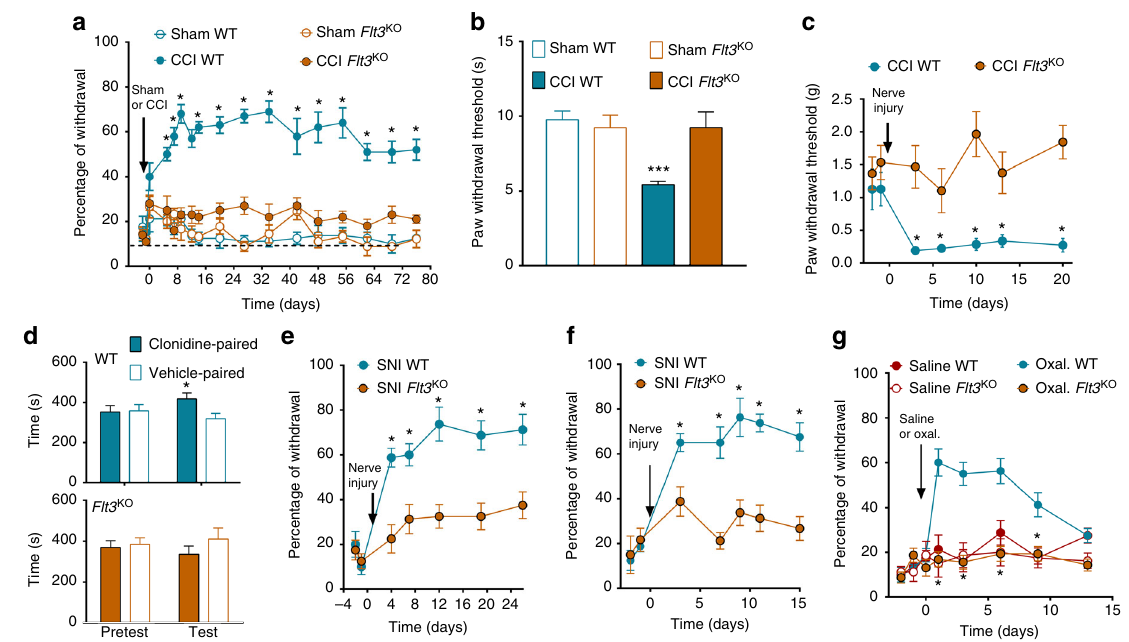
Fig. 3 FLT3 is critical for the development of pain hypersensitivity. a – g Flt3 -knockout ( Flt3 KO ), compared to wild-type (WT) animals, showed marked reductions of hypersensitivity to mechanical nociceptive stimuli as measured by the von Frey test ( a ), thermal stimuli as measured via the Hargreaves test 14 days post-injury ( b ) and punctate tactile stimuli ( c ), and of conditioned place preference induced by clonidine-evoked analgesia 14 days post-injury ( d ). Flt3 KO mice also showed decrease of mechanical pain hypersensitivity in the spared nerve injury (SNI) model ( e ), in the sciatic nerve ligature (SNL) model ( f ) and in the oxaliplatin model of generalized peripheral neuropathic pain ( g ). All the values are means ± s.e.m. ( n = 8 except in d , n = 11). Two-way ANOVA and Dunnett ’ s test ( a – c , f ); Student ’ s t -test ( d ). Two-way ANOVA and Bonferroni ’ s test ( e , g ), * P < 0.05; ***P < 0.001 vs. Sham WT, Sham CCI, CCI Flt3 KO , or vehicle